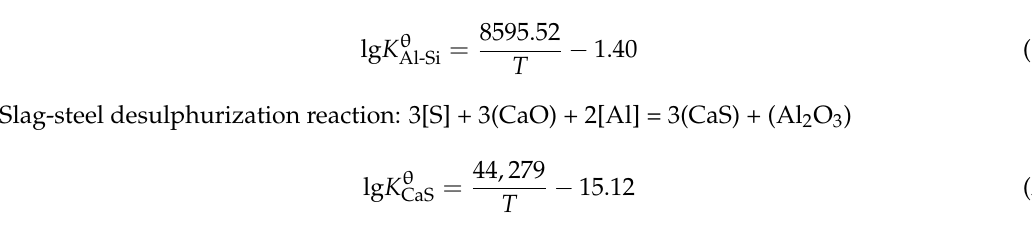
Figure 9. SEM and EDS analysis of inclusions in the casting billet. ( a ) TiN; ( b ) SiO 2 -Al 2 O 3